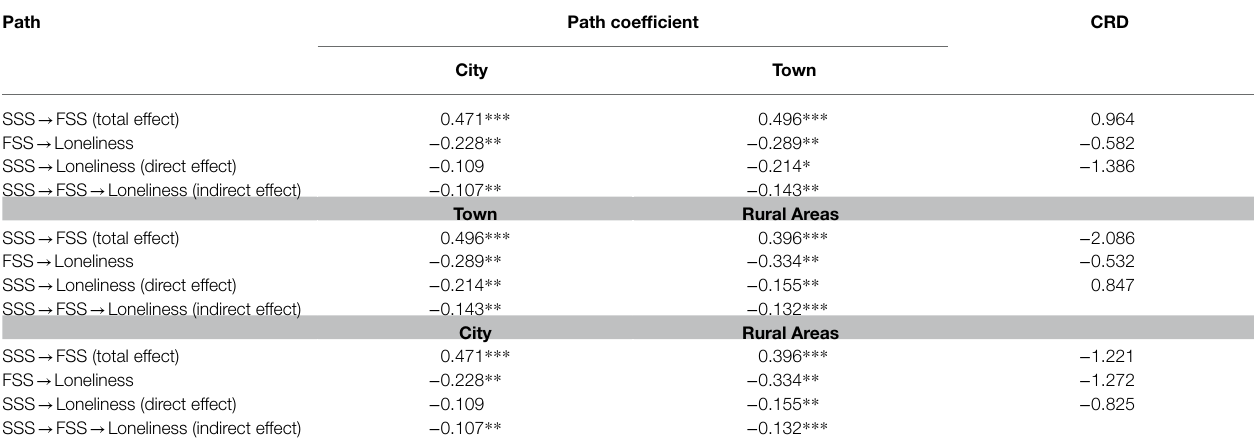
TABLE 4 | Standardized path coefficients in SEM for older adults in cities, towns, and rural areas.